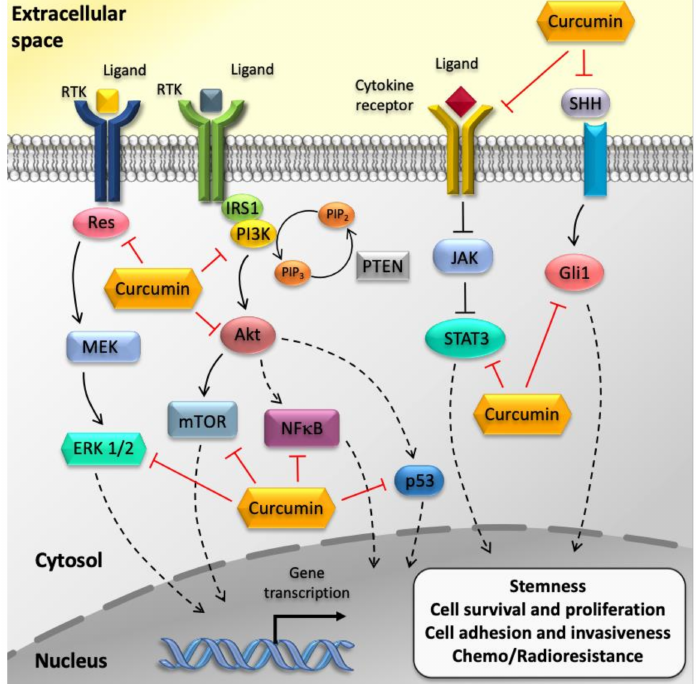
Figure 2. E ff ects of curcumin on GBM cancer stem cells (GSCs). The cartoon summarizes the major e ff ects of curcumin on GSCs. In particular, curcumin was shown to decrease malignant characteristics of GSCs by targeting core-signaling pathways such as PI3K / Akt / mTOR, JAK / STAT3, and MAPK